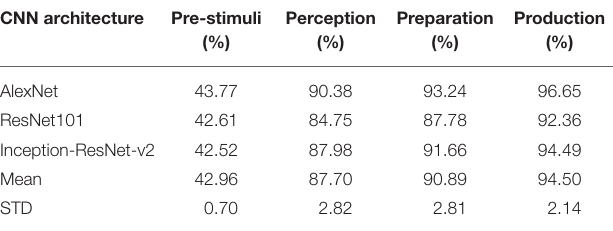
TABLE 1 | Performance comparison of AlexNet, ResNet101, and Inception-ResNet-v2 in terms of decoding accuracies with spatial-spectral-temporal